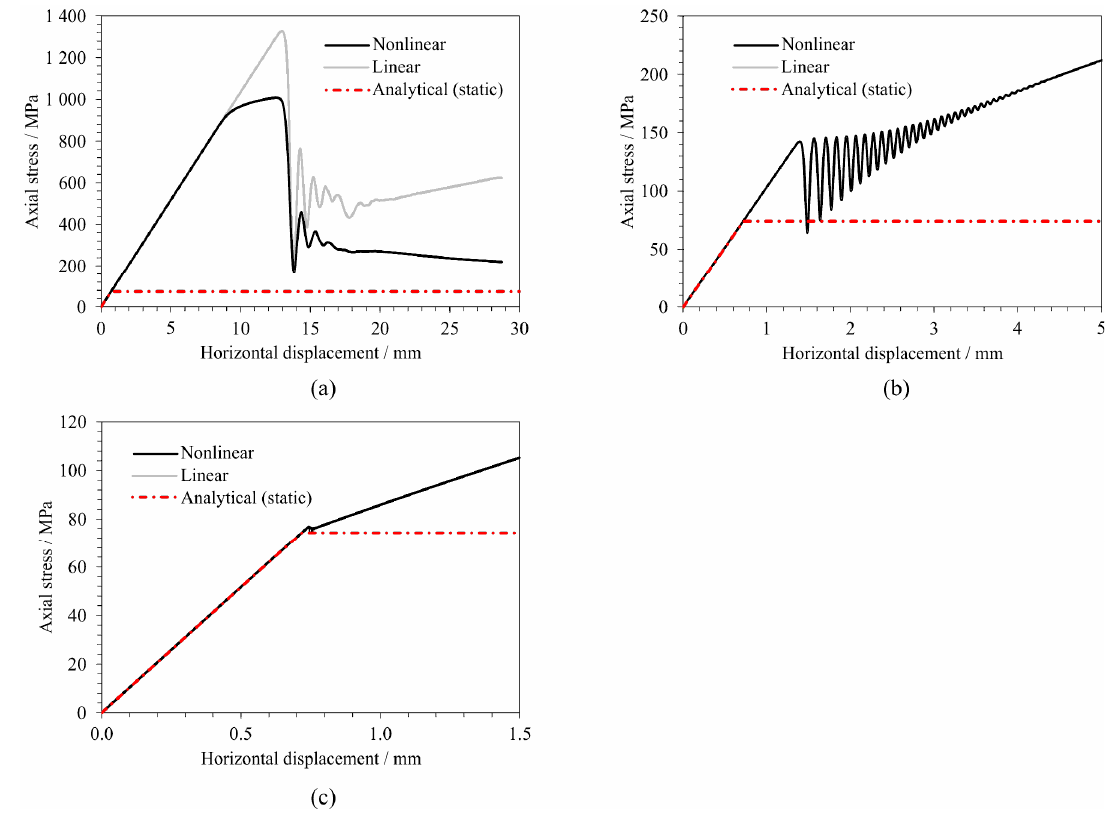
Figure 23. Relation between average axial stress and shortening of the plate for strain rates: ( a ) 2.5 × 10 − 1 s − 1 ; ( b ) 2.5 × 10 − 3 s − 1 ; and ( c ) 2.5 × 10 − 5 s − 1 .